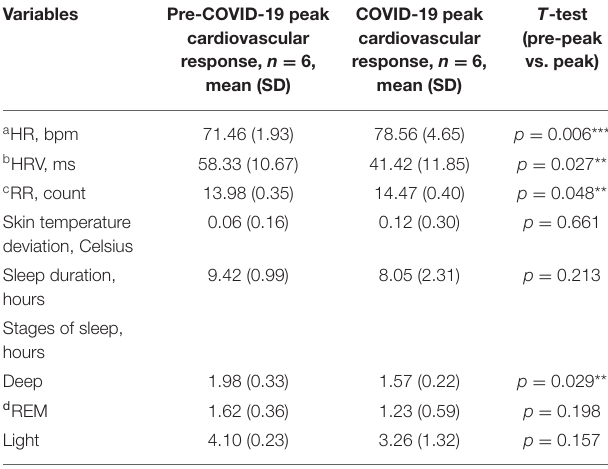
Case II TABLE 2 | Case II: comparison of physiological responses to COVID-19 surrounding the period of